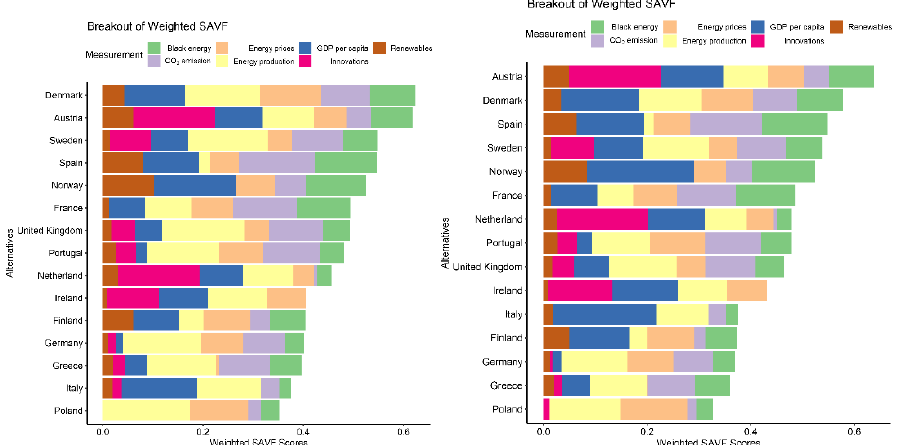
Figure 12. Influence of used variables on the overall SISED for all EU countries in 2015–2018.